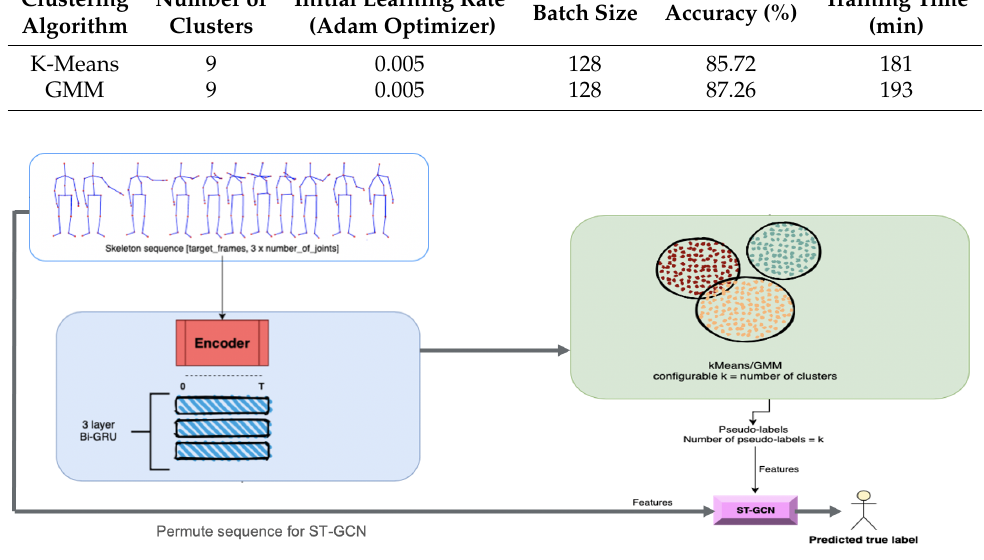
Figure 9. Architecture for 1-Classifier